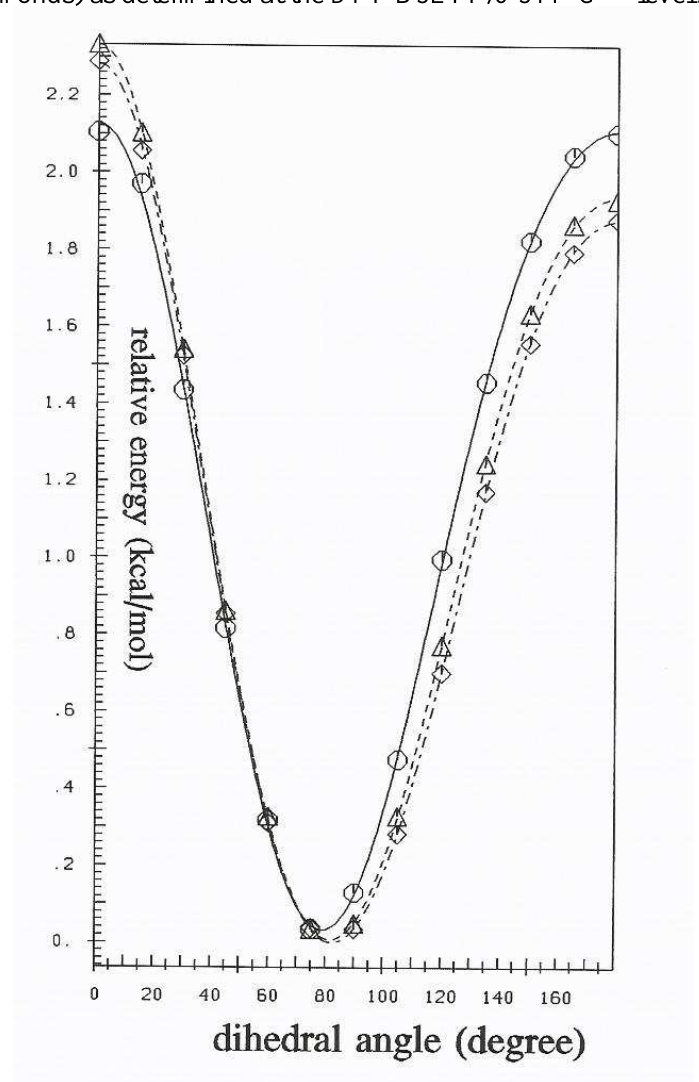
Figure 2 : Potential curves for the torsional potentials in fluoroselenonyl azide (solid line, DFT points as hexagons), in chloroselenonyl azide (dashed line, DFT points as triangles) and in bromoselenonyl azide (dashed dotted line, DFT points as diamonds) as determined at the DFT-B3LYP/6-311+G**